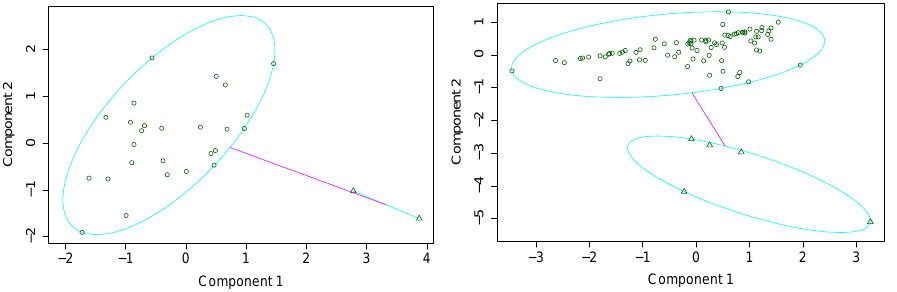
Figure 13. Same as Figure 10. The left panel shows PAM clustering with the three parameters being τ lag,i , host galaxy offset, and α cpl , while the outliers are GRBs 031203A and 060502A. The right panel shows PAM clustering with the three parameters being τ lag,i , β X11hr , and E iso,52 , while the outliers are GRBs 050416A, 060604A, 060605A, 080319B, and 100621A.